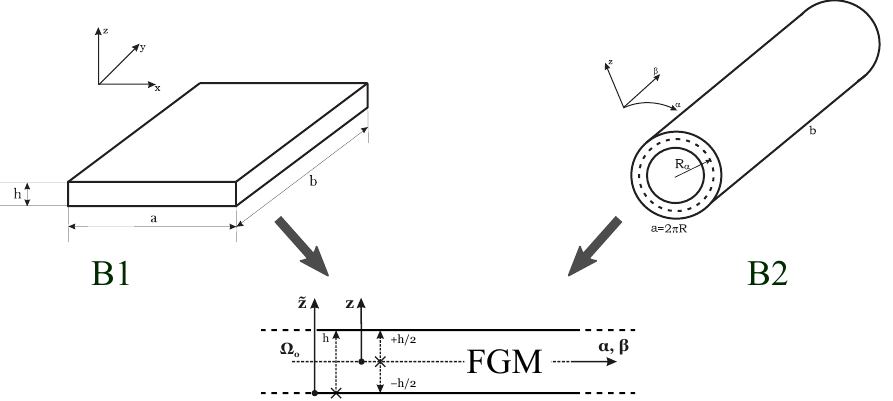
Figure 1. Geometrical data and coordinate system for plates and cylinders. The figure also shows the stacking sequence used in Benchmarks 1 and